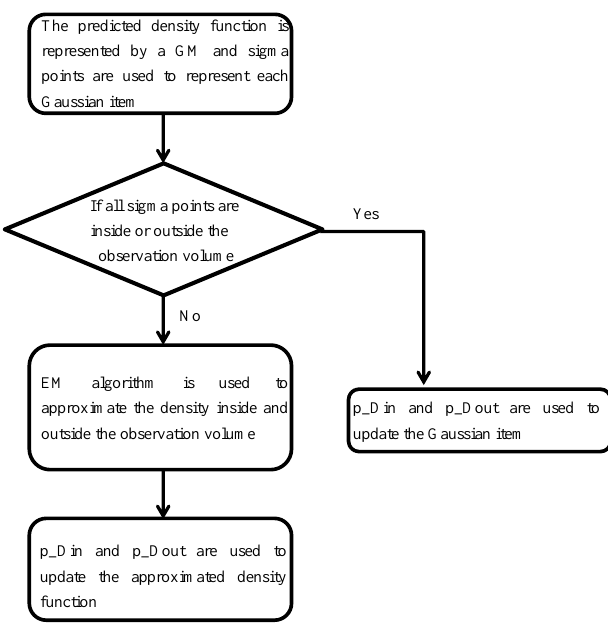
Figure 2. Estimation for objection outside the observation volume. EM: expectation